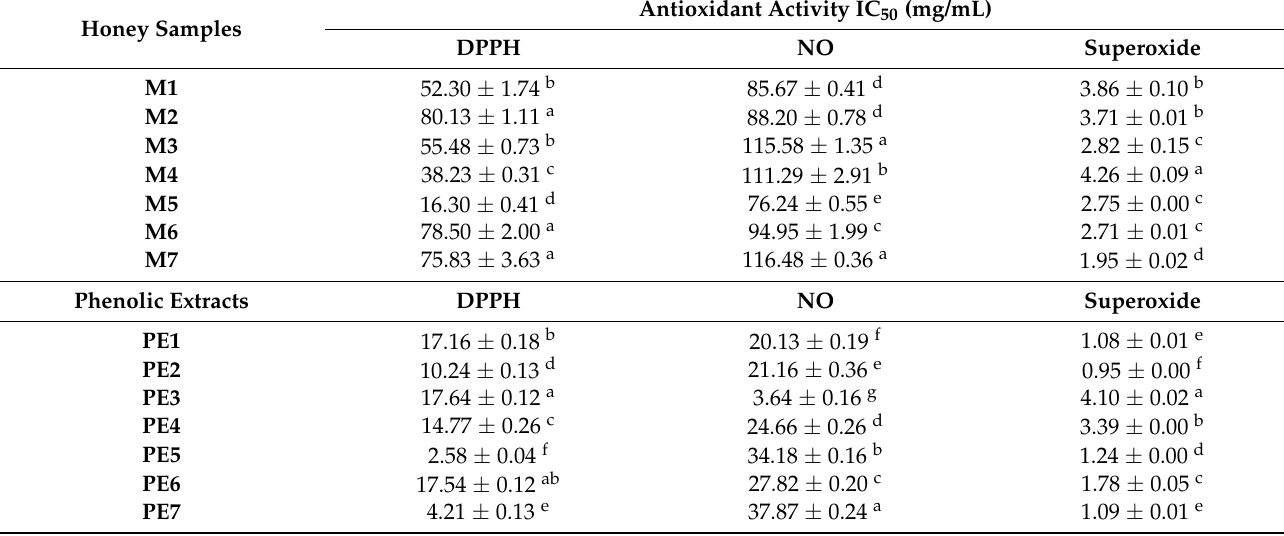
Table 7. Data presenting the different antioxidant activity (DPPH, NO and superoxyde inhibition) of Euphorbia honey samples (M1, M2, M3, M4, M5, M6, M7) and their own phenolic extract (PE1, PE2, PE3, PE4, PE5, PE6, PE7). The results of M2 and M3 samples were previously published [13]. Reproduced with permission from Oumaima Boutoub et al., Antioxidant activity and enzyme inhibitory potential of Euphorbia resinifera and E. officinarum honeys from Morocco and plant aqueous extracts; published by Springer Nature,